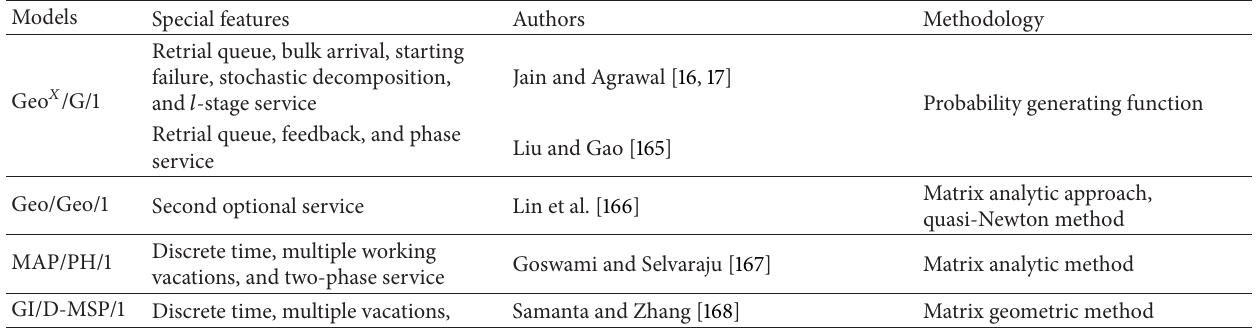
Table 6: Recent literature on discrete queueing model with phase